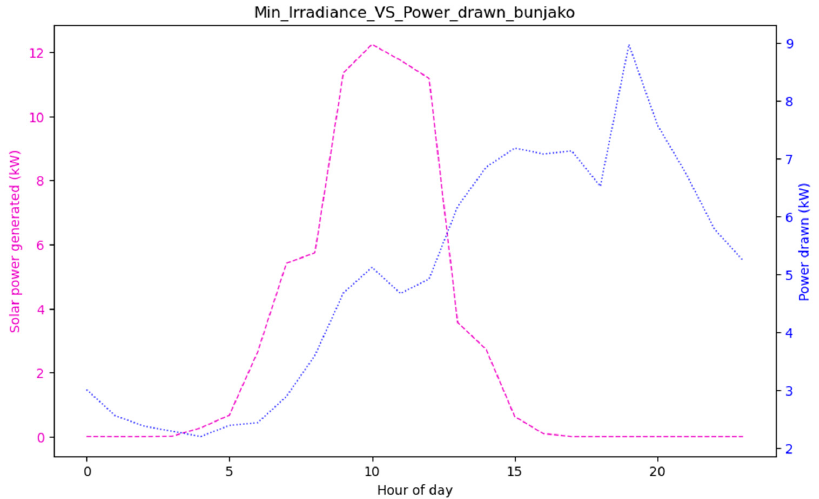
Figure 16. Comparisons between average hourly power consumed (in kW, doted line) and estimated solar power generated (in kW, dashed line) at Bunjako Island (22–28 February 2022). Figure 17 represents measurements of the microgrid model before DSM. The model takes irradiance and demand data from the measurements, and accordingly, the profile of deferrable loads is decided on based on the peak and base load profile.